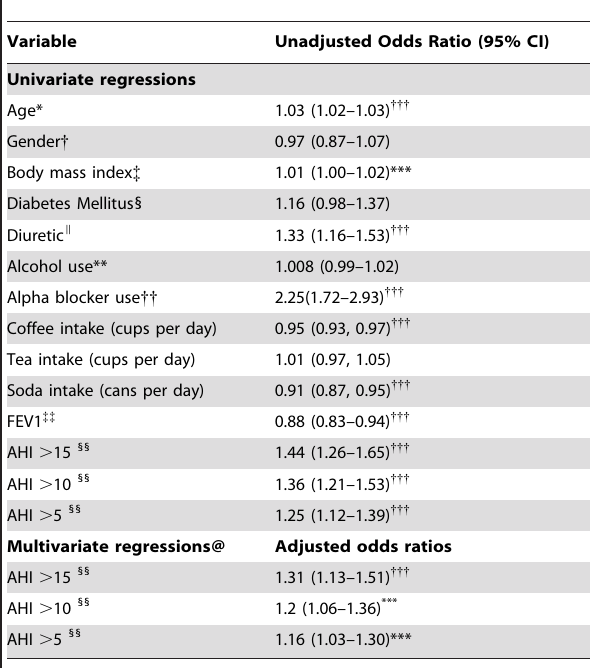
Table 3. Unadjusted And Adjusted Odds Ratios Of Variables Associated With Nocturia.